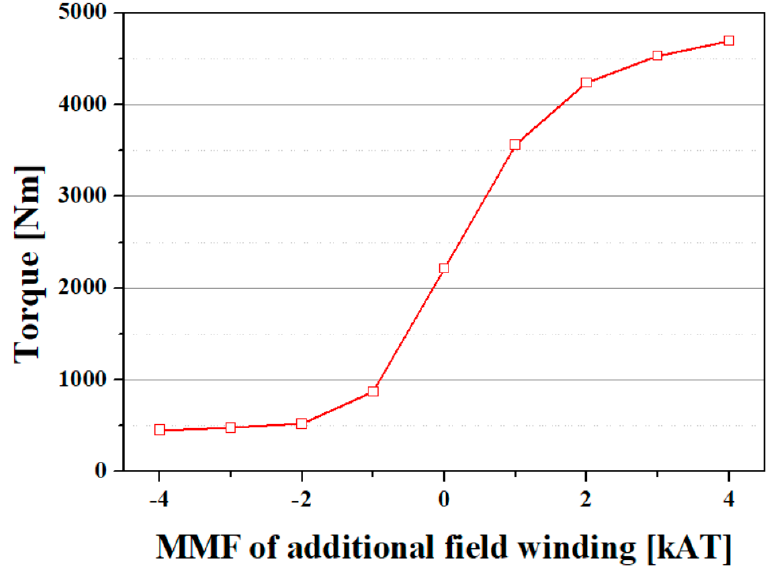
Figure 22. Torque curve according to the MMF of the additional field winding.